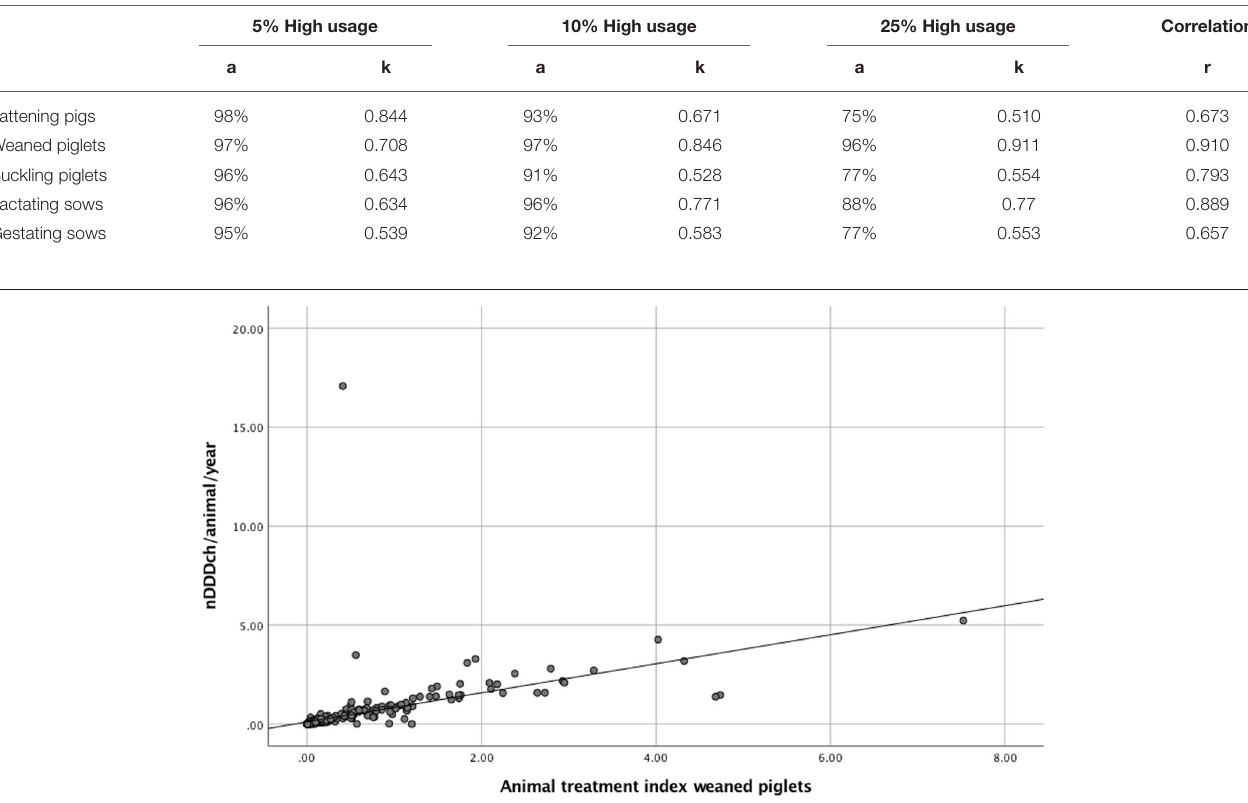
TABLE 7 | Agreement ( a ) in percent when defining 5, 10, and 25% high usage farms by calculating AMU with either ATI or nDDDch/animal/year for five age categories (fattening pigs, weaned piglets, suckling piglets, lactating and gestating sows), interrater reliability between both indicators expressed as Kappa coefficient ( k ) and correlation between both indicators displayed using Spearman‘s Rho ( r ) coefficients.